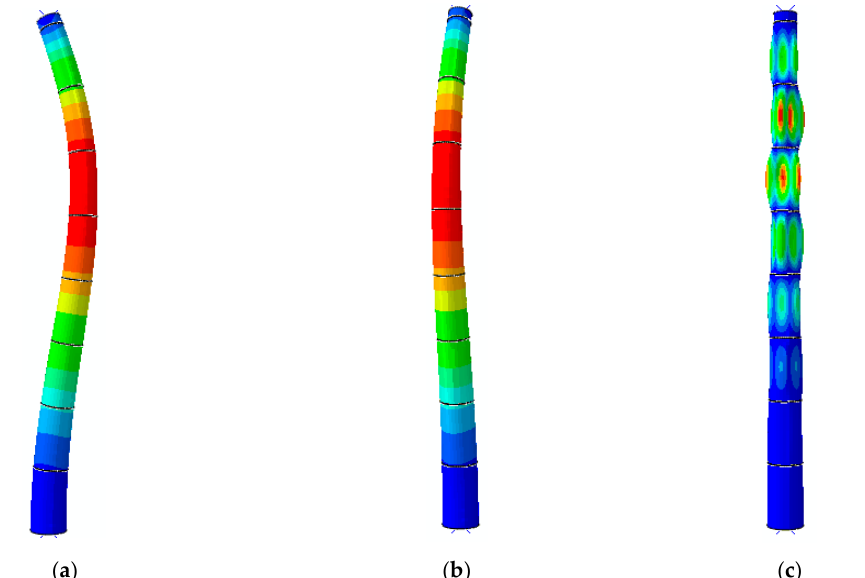
Figure 14. Buckling analysis of Tower I under the gravity of wind turbines. ( a ) Mode 1, ( b ) Mode 2, ( c ) Mode 3.